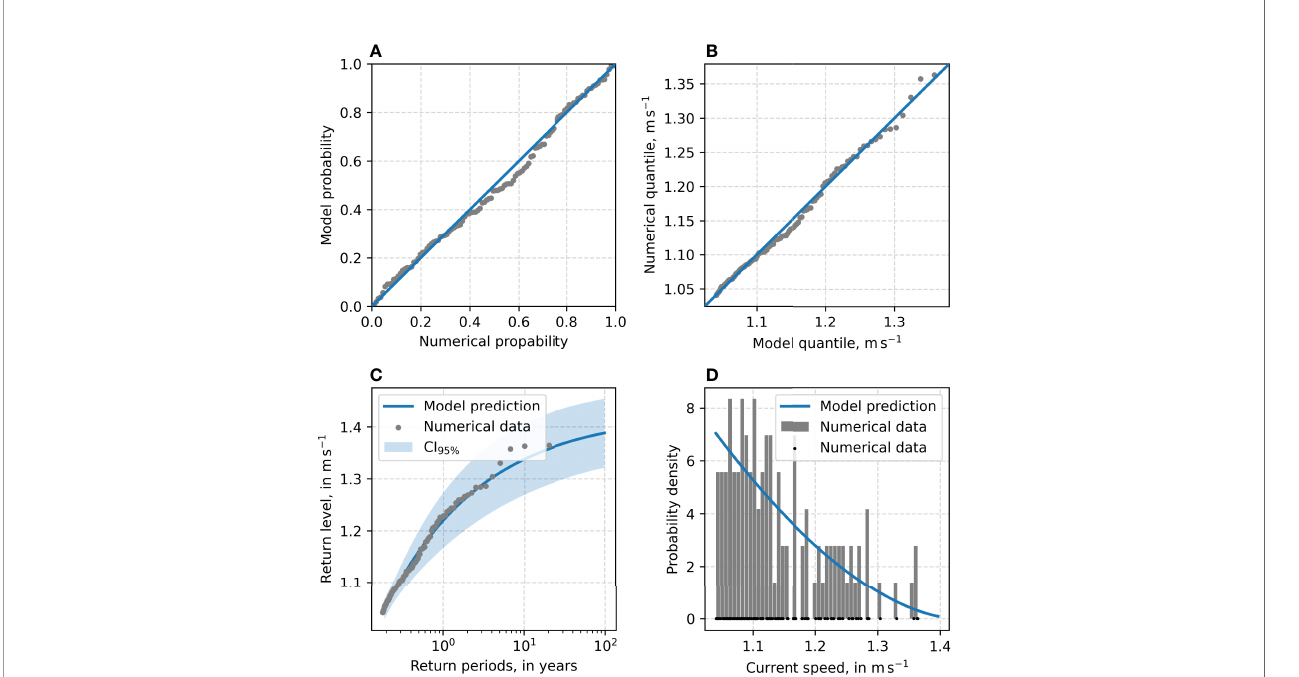
FIGURE 12 | Diagnostic plot for the GPD excess model fi tted to 3-hourly current for the node at P3. (A) p-p plot, (B) q-q plot, (C) return level plot, and (D) density plot.